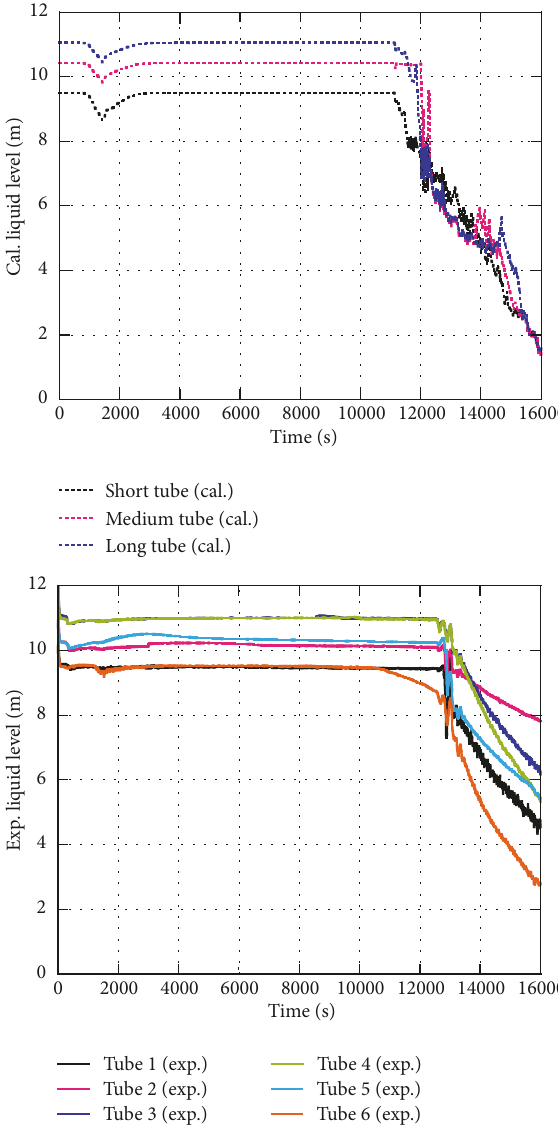
Figure27:TR-LF-16testandRELAP5resultsforSGU-tubeupflow- side collapsed liquid level in loop